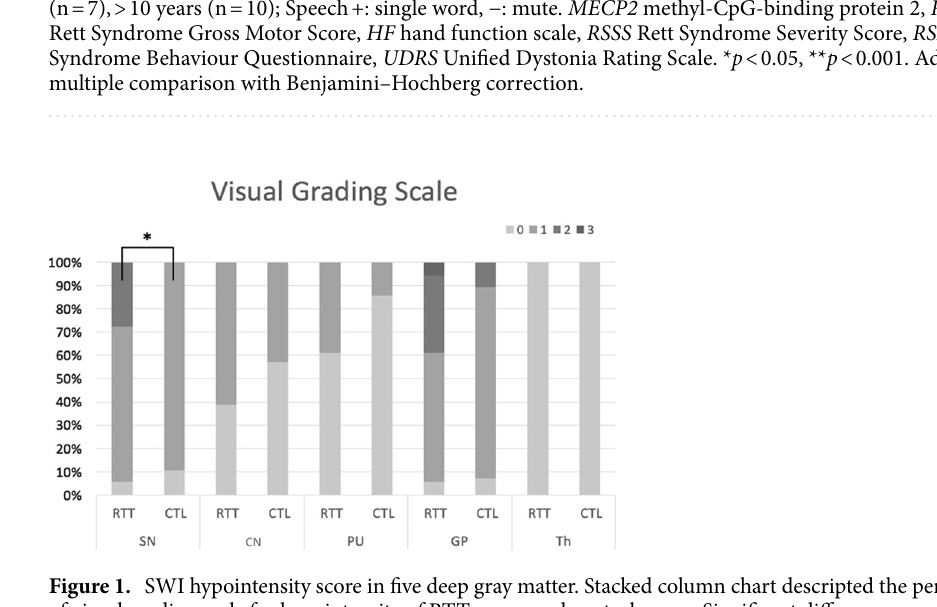
Figure 1. SWI hypointensity score in five deep gray matter. Stacked column chart descripted the percentage of visual grading scale for hypointensity of RTT group and control group. Significant difference was noted in substantia nigra (p = 0.014). Generally, hypointensity signal was higher in RTT group than the controls, except the signal in thalamus. ( CTL control group, RTT Rett syndrome, SN substantia nigra, CN caudate nucleus, PU putamen, GP globus pallidus, TH